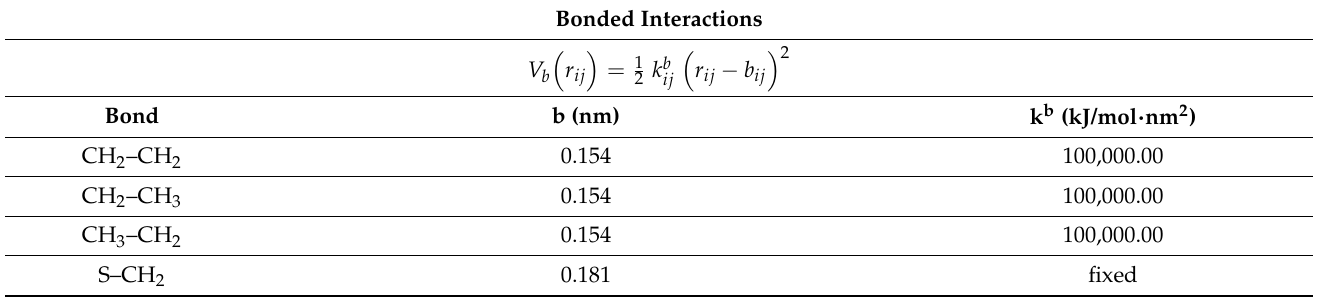
Table A2. Bonded interactions of the atomistic force field for the model PE/Au